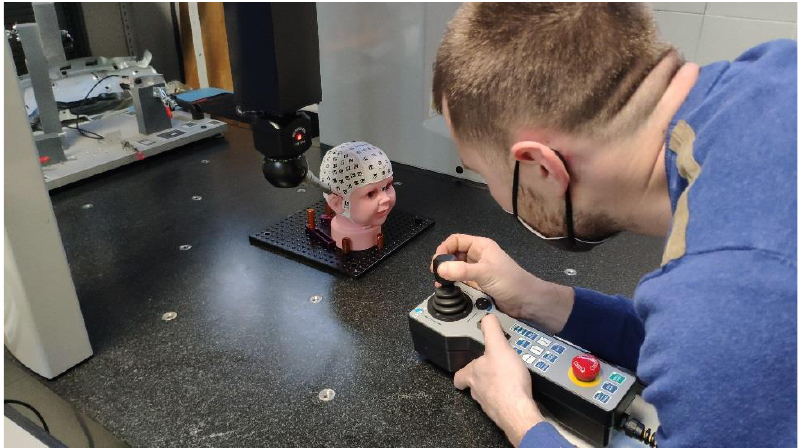
Figure 5. CNC CMM: operator pointing at a label corner to register its coordinates.